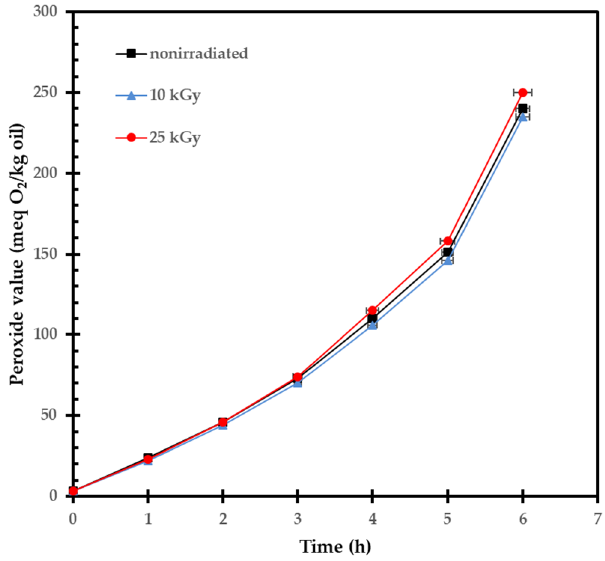
Figure 2. Induction periods of RH seed oils extracted from non-irradiated, 10 kGy-, and 25 kGy- irradiated RH fruits. Table 3. Phenolic constituents and in vitro antioxidant activity of non-irradiated, 10 kGy-, and 25 kGy-irradiated RH